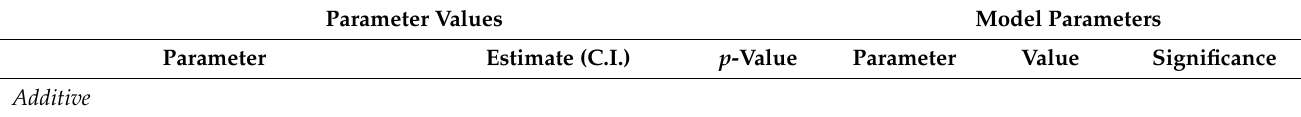
Table 4. Multivariate Geospatial Analysis for